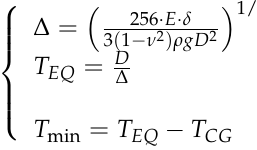
( b ) Figure 6. Elliptical initial structure converted by equivalent circular plate: ( a ) circular equivalent plate; ( b ) high-steepness elliptic mirror. 4.2. Mirror Shape Optimization In the previous section, we described the completed construction of the initial struc- ture of the solid mirror, which was unable to meet lightweight design requirements.